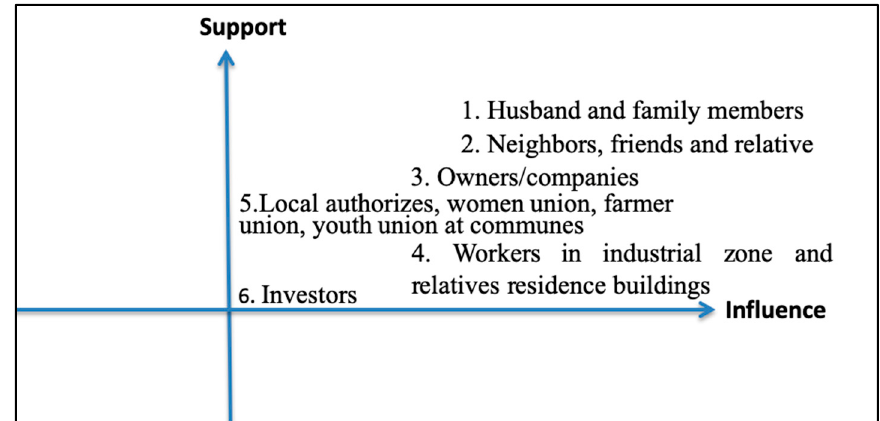
Figure 3. Support and influence of stakeholders on women of ALA projects. Source: result of three group discussions, 2018.